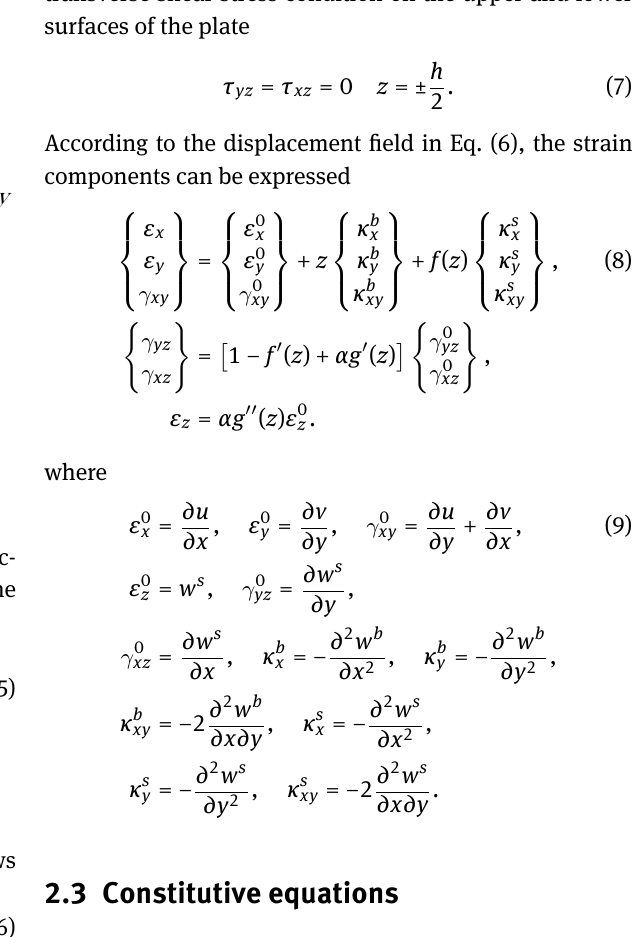
Figure 1: Geometry of the FG plate.